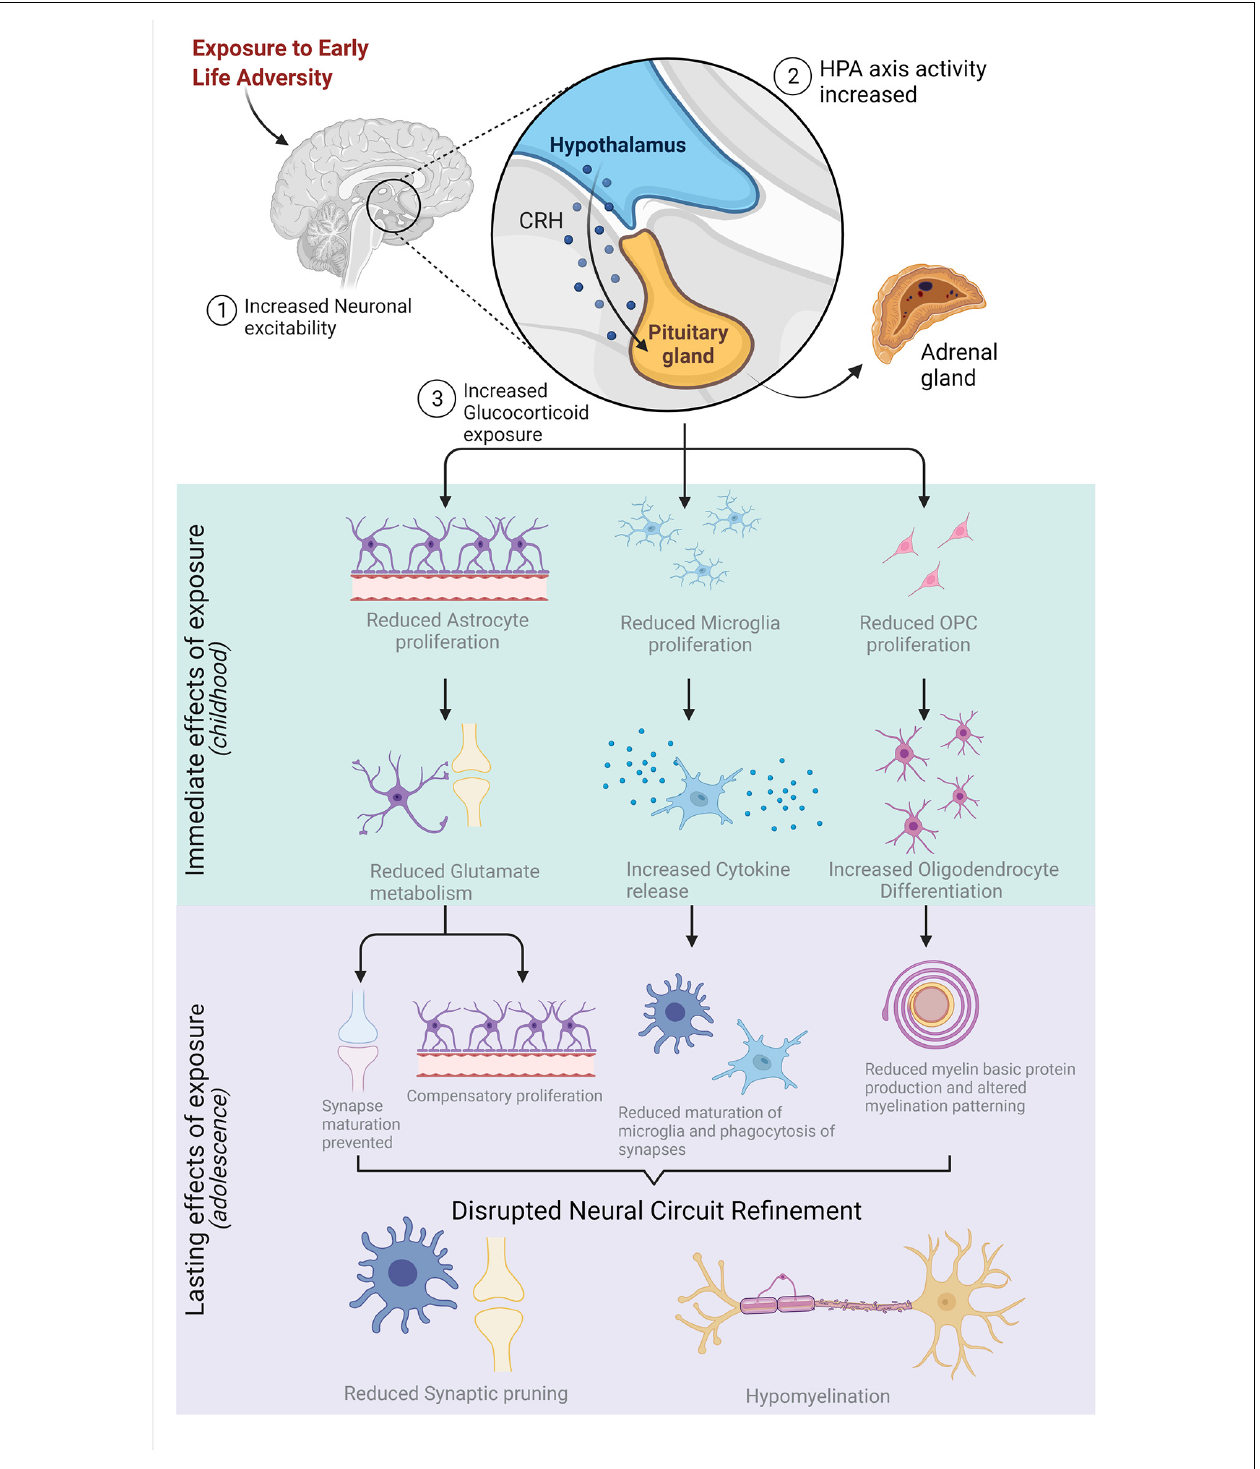
FIGURE 3 | Early-life adversity (ELA) stimulates neuronal activity, increasing the activation of the hypothalamic-pituitary-adrenal (HPA) axis which leads to an over-production of glucocorticoids. Increased exposure to glucocorticoids immediately reduces the proliferation of astrocytes, microglia, and oligodendrocyte precursor cells (OPCs) which impacts the function and maturation of these glial cells. The lasting effects of ELA exposure on glia structure and function are highlighted in purple and, collectively, disrupt neural circuit refinement in adolescence by reducing synaptic pruning and resulting in hypomyelination. Figure created with